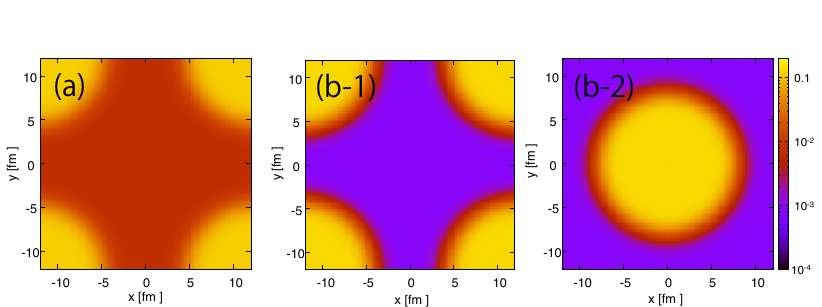
Figure 1. Calculated nucleonic density distribution (log scale) of the bcc phase in the x y plane at ρ = 0 . 03 fm − 3 in the planes z = | z | fm (panels (a) and (b-1)), z = 0 (b-2). The temperature is T = 5 B max MeV (b) and T = 10 MeV